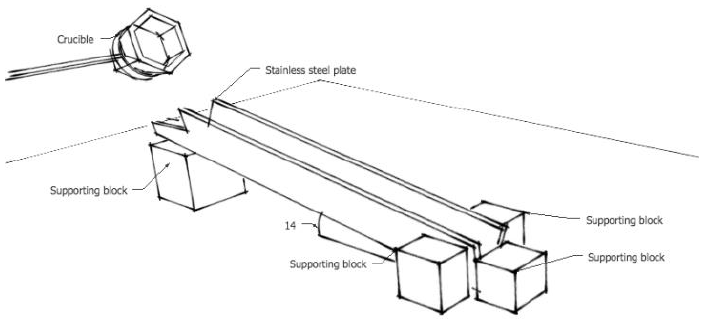
Figure 4. The experimental set-up of the inclined plane test.